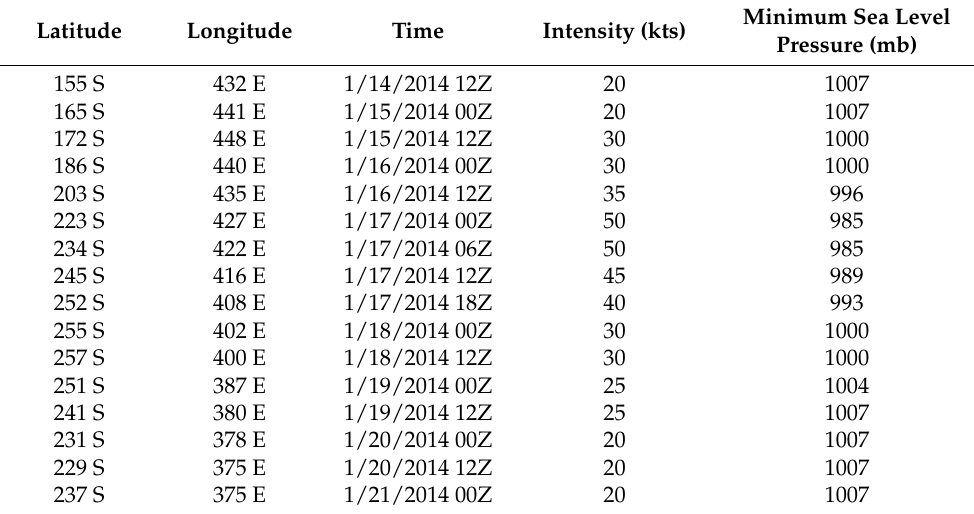
Note: Times are given in UTC time (denoted as Z).